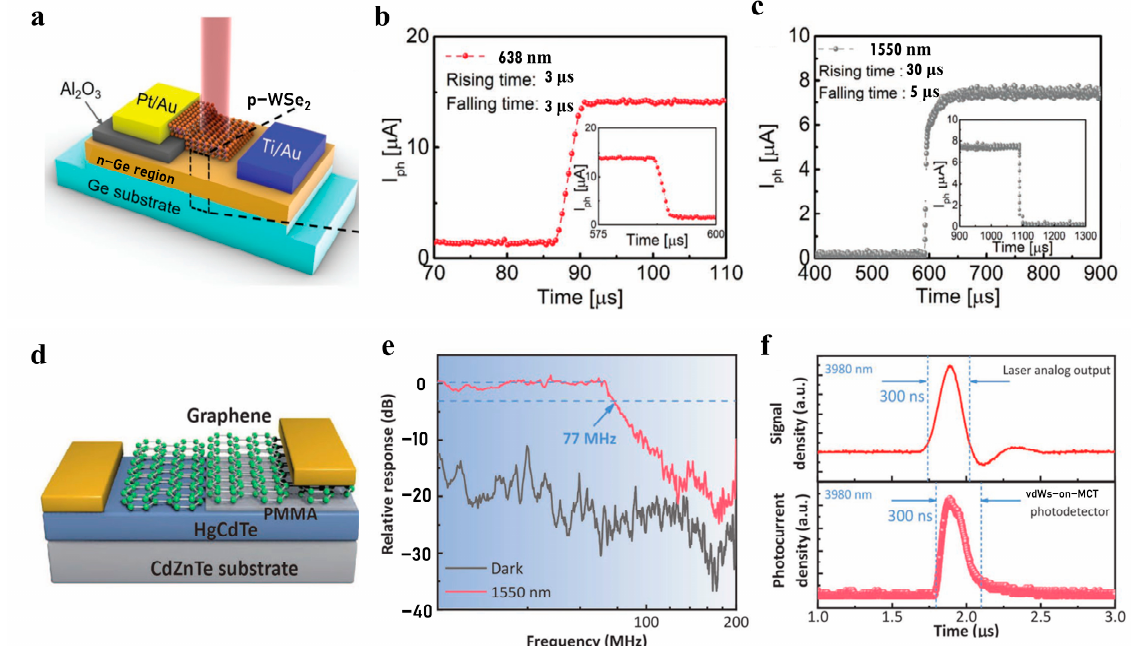
Figure 6. Fast-response infrared photodetection. ( a ) Optical microscope image of WSe 2 /Ge infrared detector [105] (copyright 2021, John Wiley and Sons). Its rising and falling time under light modulation at ( b ) 639 nm and ( c ) 1550 nm [105] (copyright 2021, John Wiley and Sons). ( d ) Schematic diagram of graphene/HgCdTe(MCT) van der Waals heterojunction photodetector [106] (copyright 2021, John Wiley and Sons). ( e ) Relative response versus switching frequency [106] (copyright 2021, John Wiley and Sons). ( f ) Time response of graphene/HgCdTe(MCT) photodetector under 3980 nm pulse laser [106] (copyright 2021, John Wiley and Sons).